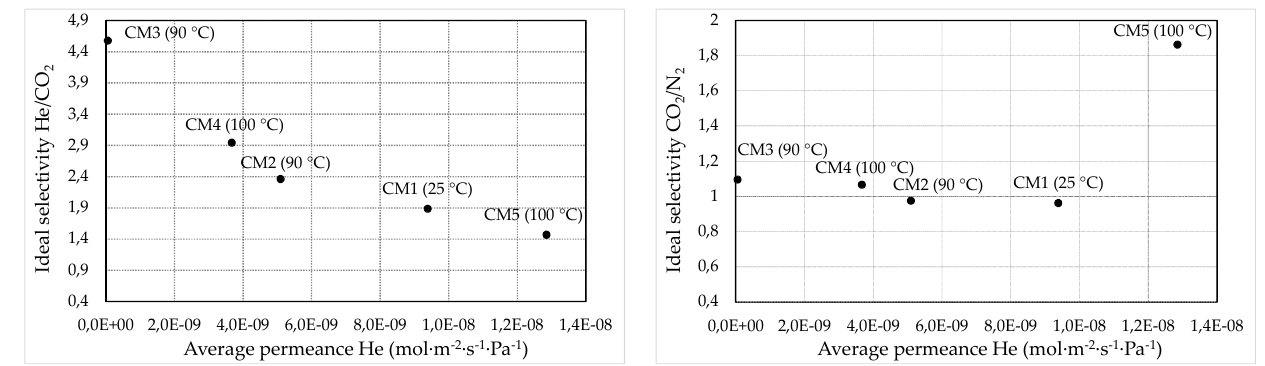
Figure 9. Ideal selectivity values of the gas pairs ( a ) He/N 2 and ( b ) CO 2 /N 2 , with respect to the average values of He permeance for all Carbon/Vycor ® membranes, that have been acquired over the entire feed pressure range applied.